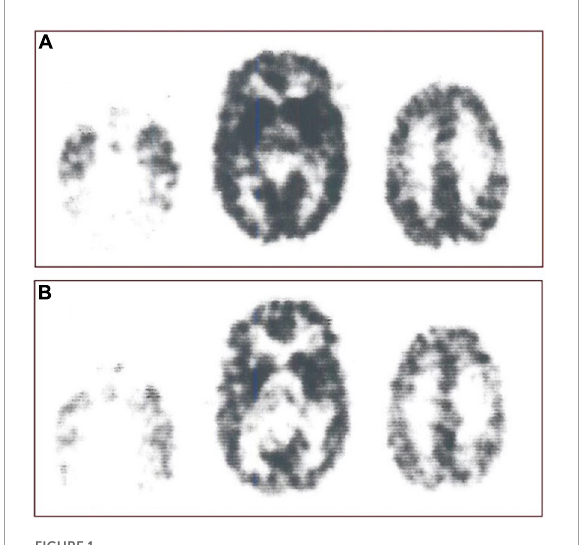
FIGURE1 Receptor blockade. Study of interaction N-[ 11 C]methylspiperone with exogenously administered unlabeled haloperidol as inhibitor of D 2 -like dopamine receptors from experiments reported by Wong et al. (1986b), showing original N-[ 11 C]methylspiperone ([ 11 C]NMSP) positron emission tomography sections before ( A , top row) and after ( B , bottom row) the ingestion of haloperidol. Images were obtained 45 min after injection of [ 11 C]NMSP in both cases. From left to right in each row are the images from the three planes of the NeuroEcat camera (separated by 32 mm), demonstrating the temporal tips and cerebellar regions, basal ganglia, and cortical regions, and the frontoparietal region, scaled to the same intensity maximum and normalized for injected dose. Marked blockade of the uptake of the tracer in the basal ganglia is evident in center scan of Panel (B)